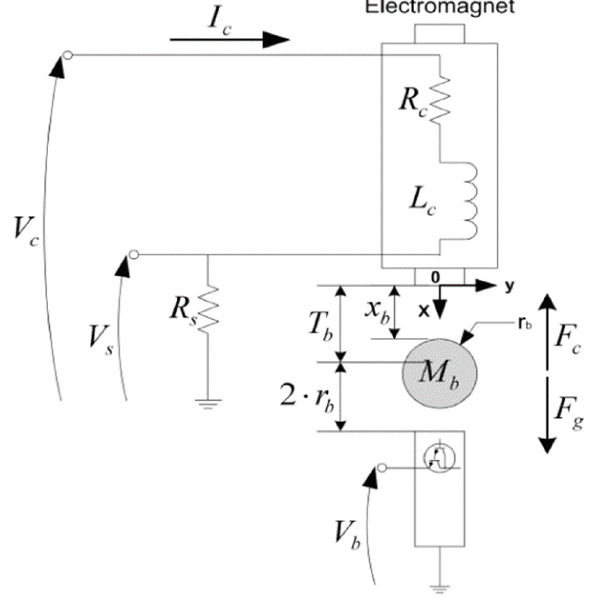
Figure 4. Schematic of the Magnetic Levitation System.